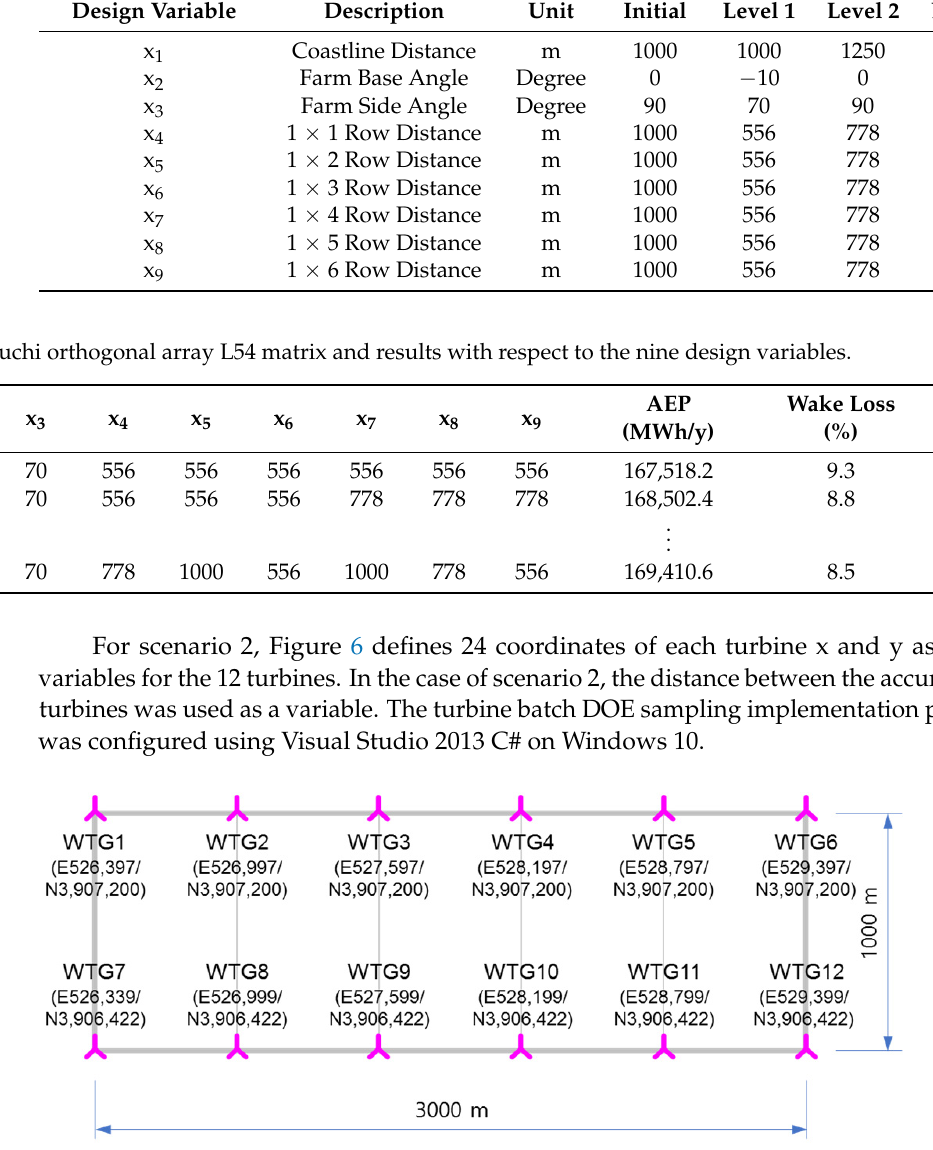
Table 1. The nine design variables and their levels.